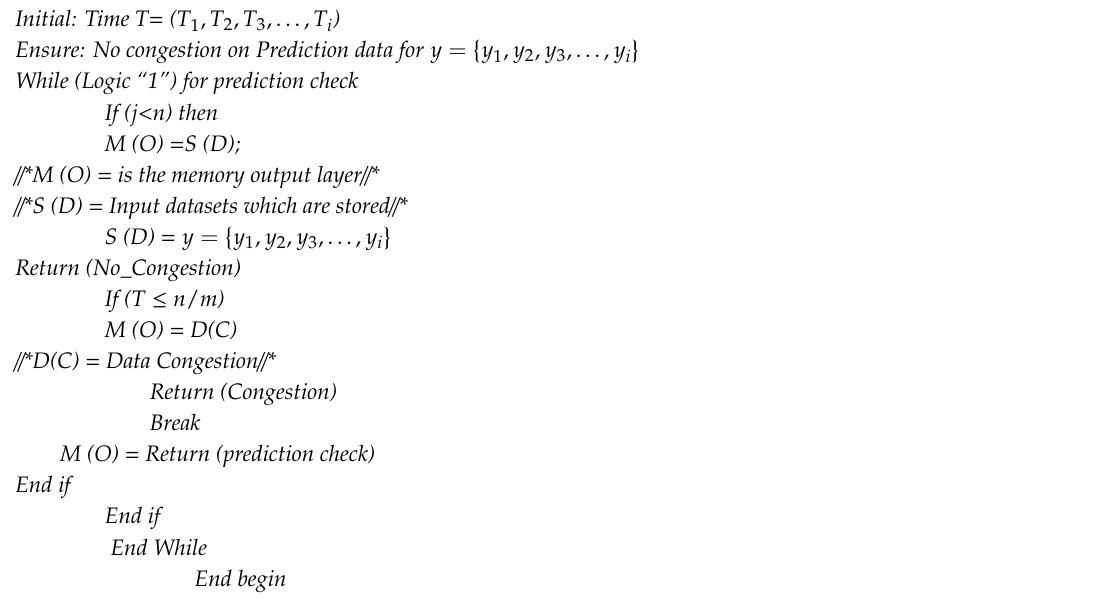
Algorithm 2. Agile learning of Bayesian networks for congestion check in wearable